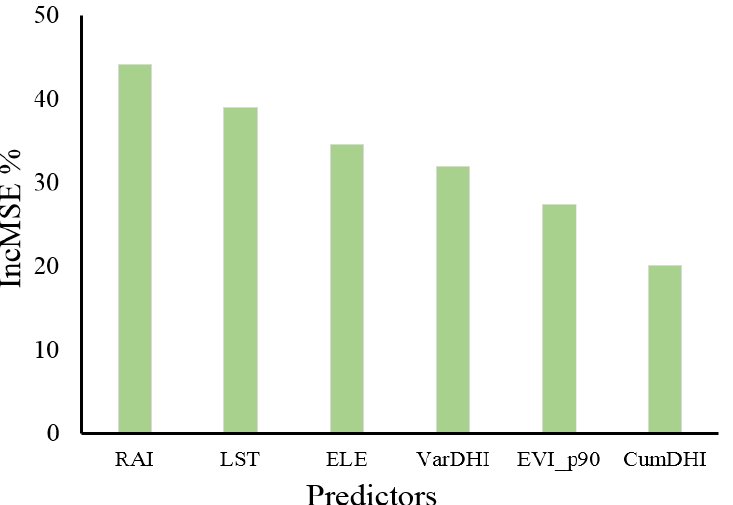
Figure 3. Relative importance of the predictor variables (IncMSE, %) in random models of soil organic carbon content (SOC, ton C ha − 1 ) across the Patagonia region. RAI = mean annual rainfall, LST = land surface temperature, ELE = elevation, VarDHI = annual variation of Landsat-8 Dynamic Habitat Indices, EVI_p90 = 90th percentile of the Enhanced Vegetation Index, and CumDHI = annual cumulative productivity of Landsat-8 Dynamic Habitat